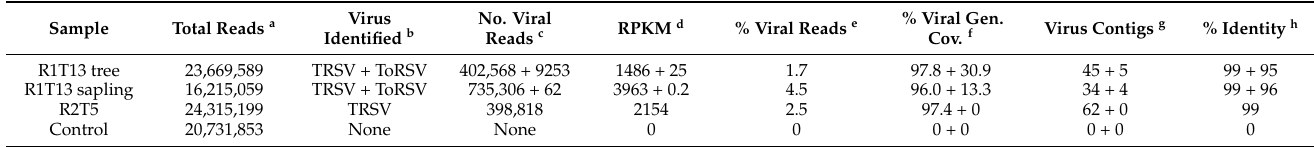
Figure 3. One- and two-year-old saplings growing underneath established pawpaw trees in an experimental orchard in Lansing, NY. Saplings may be root suckers or seedlings. Note that some saplings exhibit virus-like symptoms. The photo was taken in May 2022. Table 1. Summary of sequencing and mapping statistics from HTS